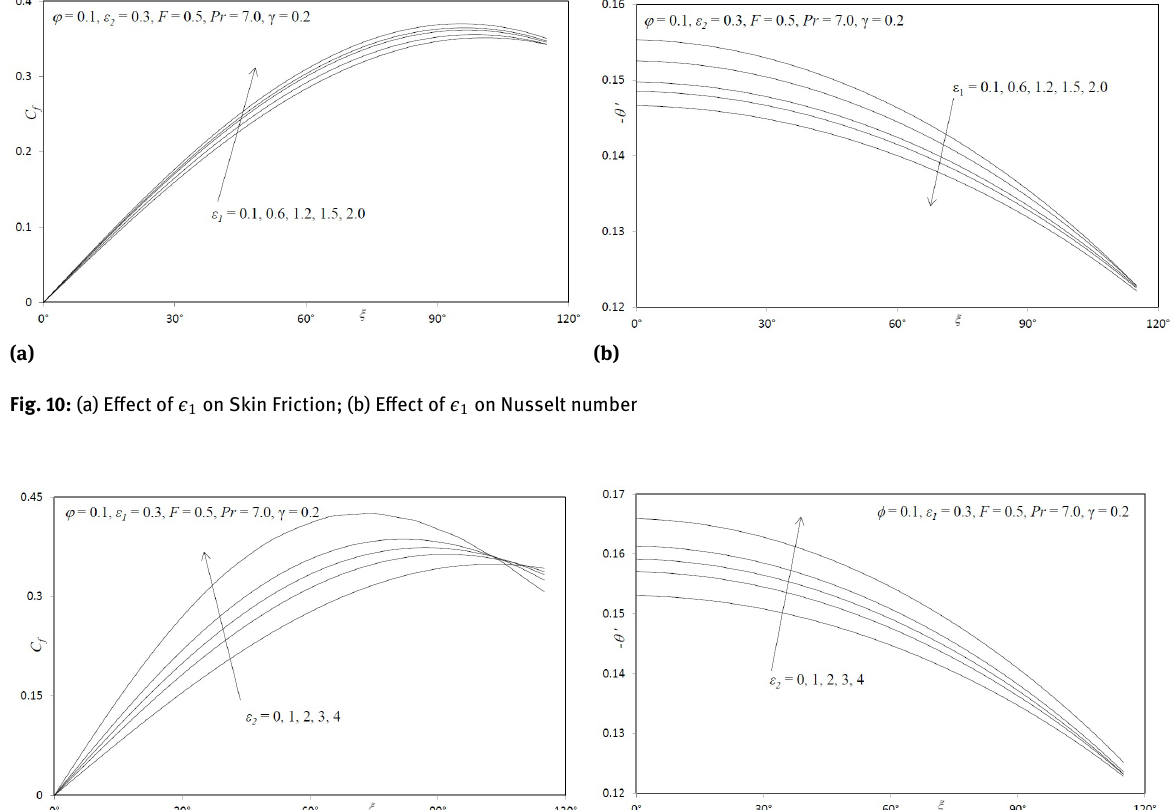
attributable to the decrease in Grashof (free convection) number which results in an acceleration in the bound- ary layer flow, as elaborated by Chen and Chen [47]. Heat transfer rate is also enhanced with increasing γ, at large values of ξ, as computed in Fig.